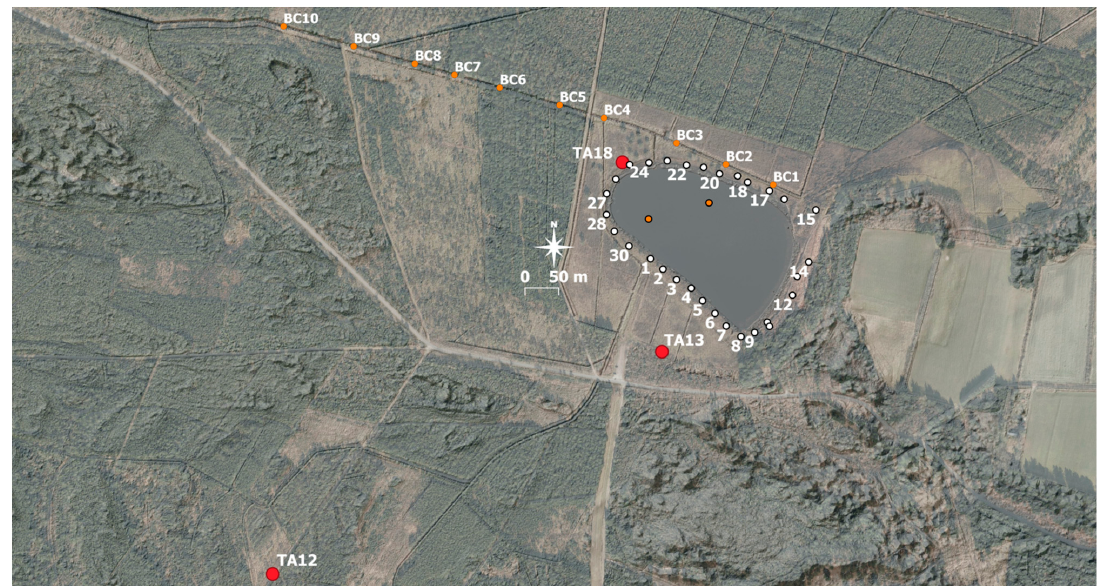
Figure 2. Sampling locations around Lake Tvorup Hul numbered 1–30 (white circles, note that not all labels for locations are included in order to increase readability). Surface water samples in the lake (two samples) and Bøgsted Ditch (BC1–10) marked with orange circles. Wells TA12, TA13, and TA18 shown with red circles (TA12 and TA13 were used to assess the groundwater end-members). The map also shows the topography.